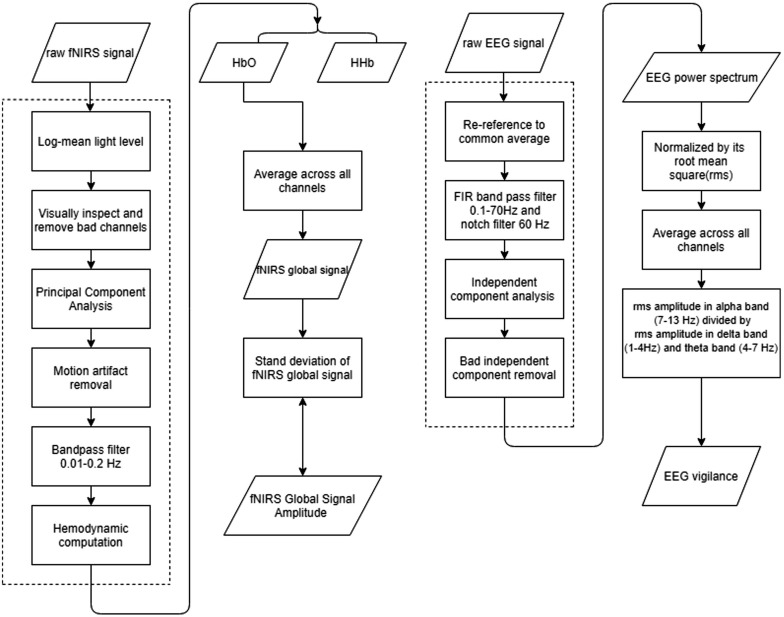
Flowchart of the data processing flowchart. (Left) fNIRS signal processing procedures, and (Right) EEG signal processing procedures. Dashed line circles the pre-processing procedures.